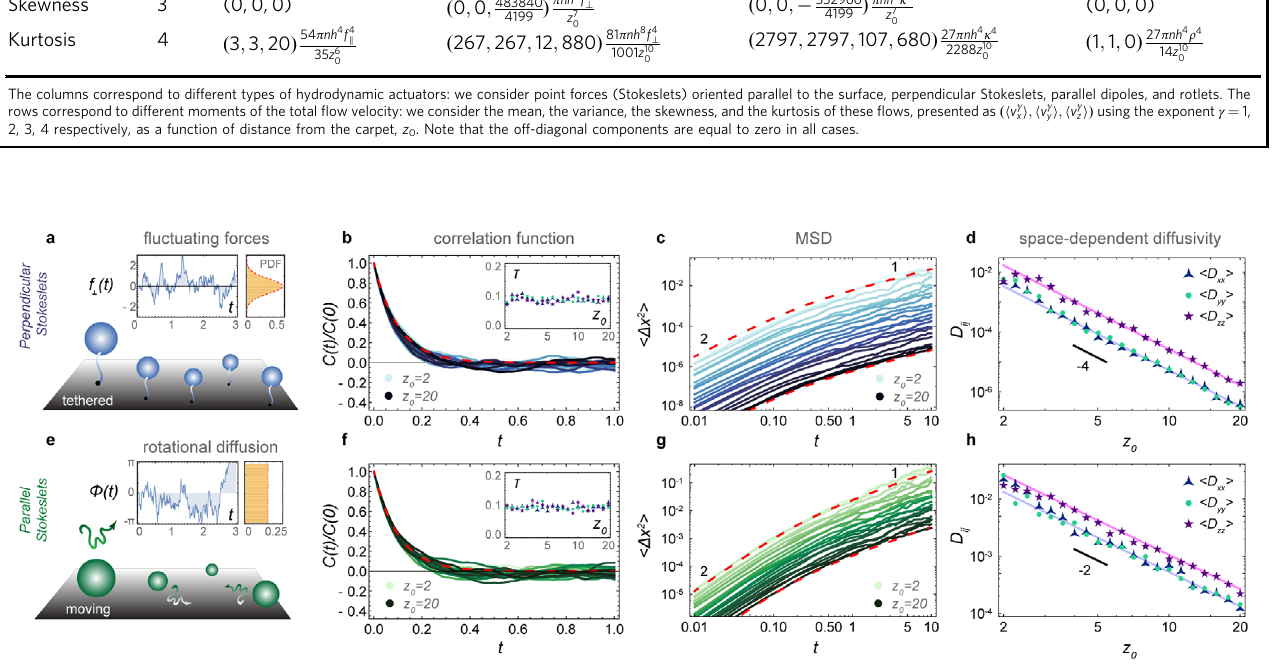
Fig. 2 Diffusion driven by an active carpet. For a – d the surface is covered with sessile perpendicular Stokeslets with independent random forces. Also see Supplementary Movie 1. For e – h the surface is covered by parallel Stokeslets moving along a surface with a constant velocity V and rotational diffusion D r . For both cases we simulate the motion of tracer particles subject to these active fl uctuations, ensemble-averaged over N e = 100 independent tracer trajectories, as a function of their initial distance from the surface, z 0 . a Diagram and typical time course of a random force f ( t ) described by an Ornstein – Uhlenbeck process. b Velocity correlation function (VCF) of the tracer velocity over time. Blue lines show different values of z 0 , each ensemble- averaged, and the red dashed line is the prediction of Eq. (48). The inset shows that the resulting correlation time τ is independent of z 0 . c Mean-squared displacement (MSD) for different values of z 0 , each ensemble-averaged, transitioning from ballistic to diffusive motion. The red dashed lines show the theoretical approximation of Eq. (3) for z 0 = 2, 20. d Anisotropic diffusivity in the directions parallel (blue, green) and perpendicular (purple) to the surface. The solid lines show the prediction of Eq. (4). e Diagram and typical time course of the orientation angle ϕ a ( t ) described by rotational diffusion. f – h are equivalent to b – d for moving